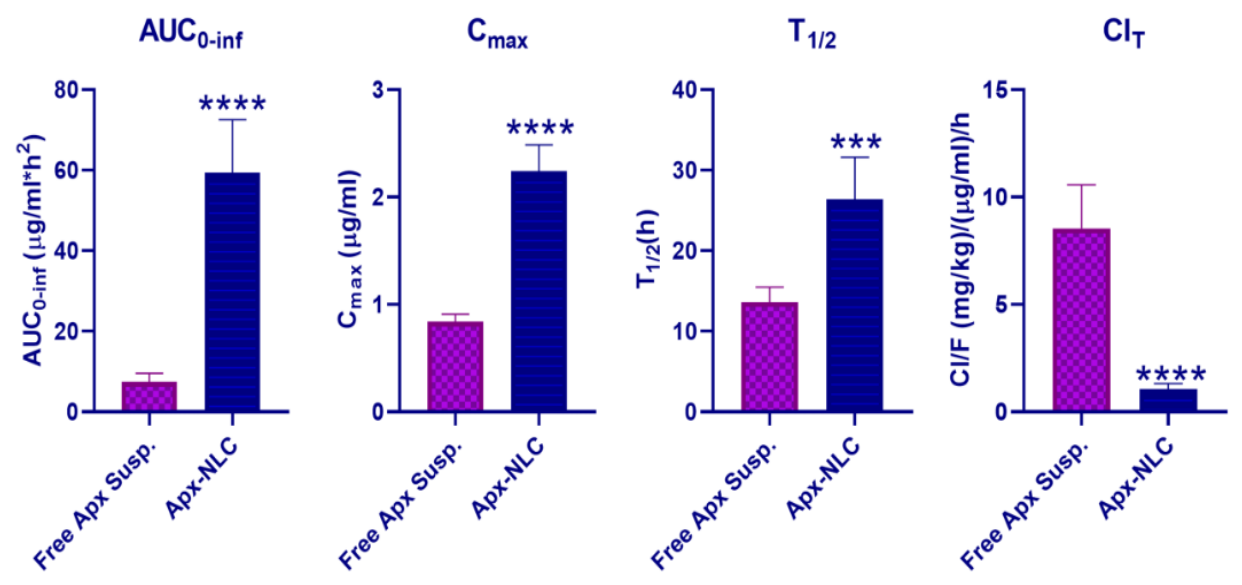
Figure 6. Statistical analysis of main pharmacokinetic parameters after oral administration of 60 mg/kg of both Apx- NLC and free Apx suspension (mean ± SD, n = 6). Note: *** and **** denote significant effects at p -values less than 0.001, and 0.0001, respectively.